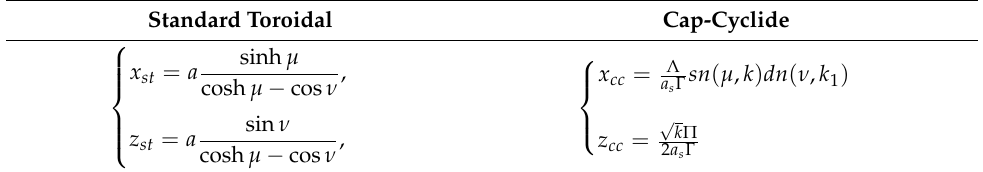
Table 1. Two-dimensional coordinate system of standard toroidal and cap-cyclide geometries. Standard